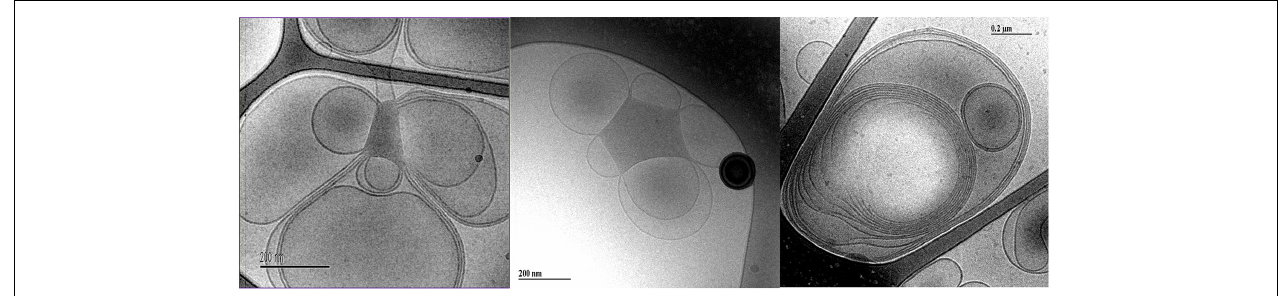
FIGURE 8 | Typical cryo-TEM images of a 10 wt% brain lipid extract dispersion in 0.9 wt% (154 mM) NaCl and 1 mM CaCl 2 . The images show large multilamellar vesicles often attached to a body of higher electron density.